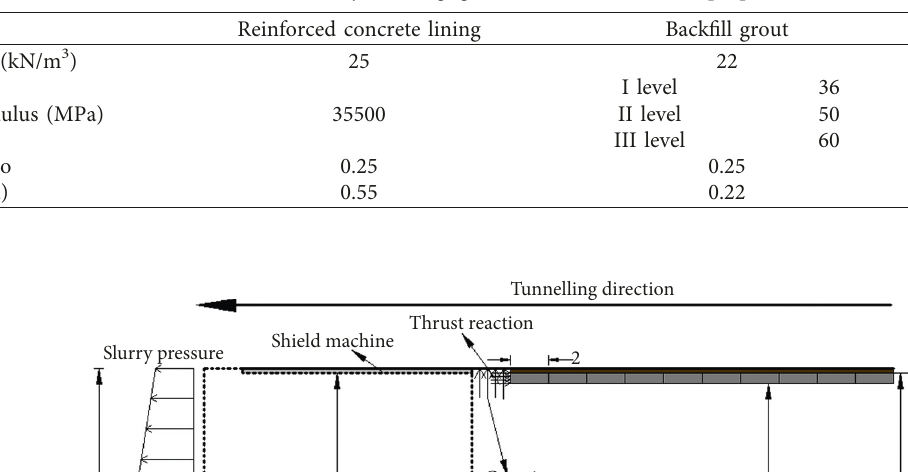
Table 3: Summary of lining, grout, and shield machine properties.